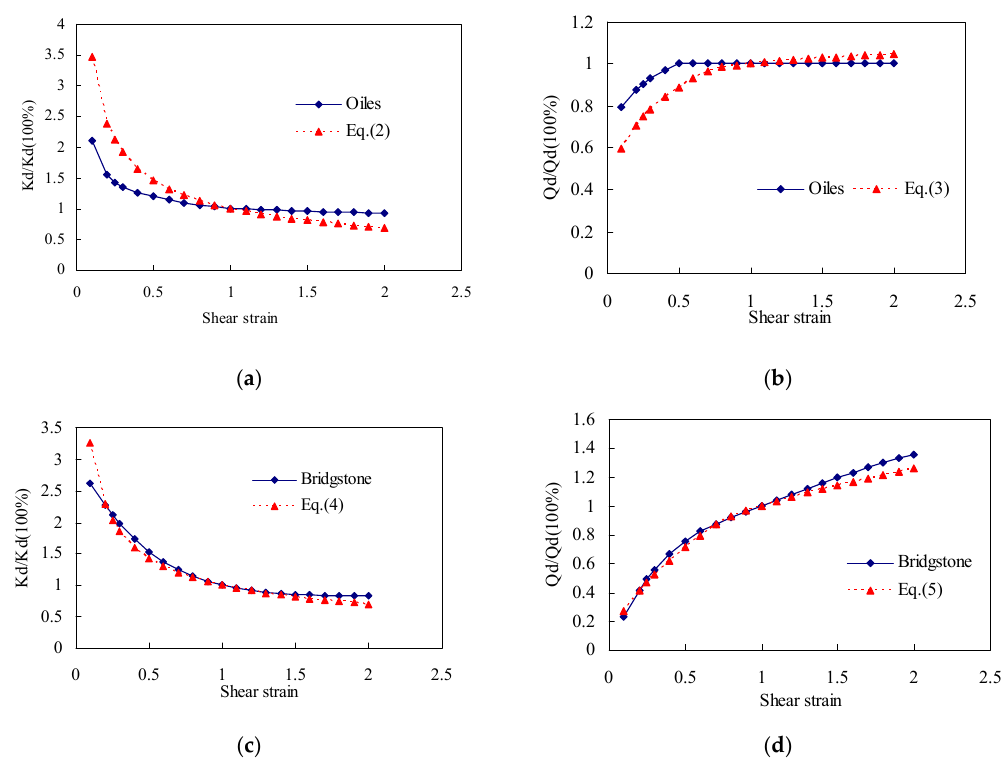
Figure 10. The difference of fitted curve of LRB and SHDR. ( a ) K d for LRB; ( b ) Q d for LRB; ( c ) K d for SHDR; ( d ) Q d for SHDR.